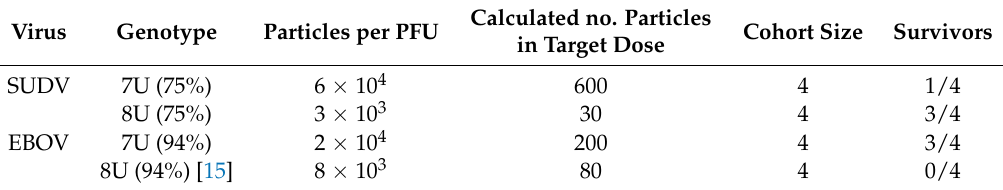
Table 1. Virus exposure stocks.